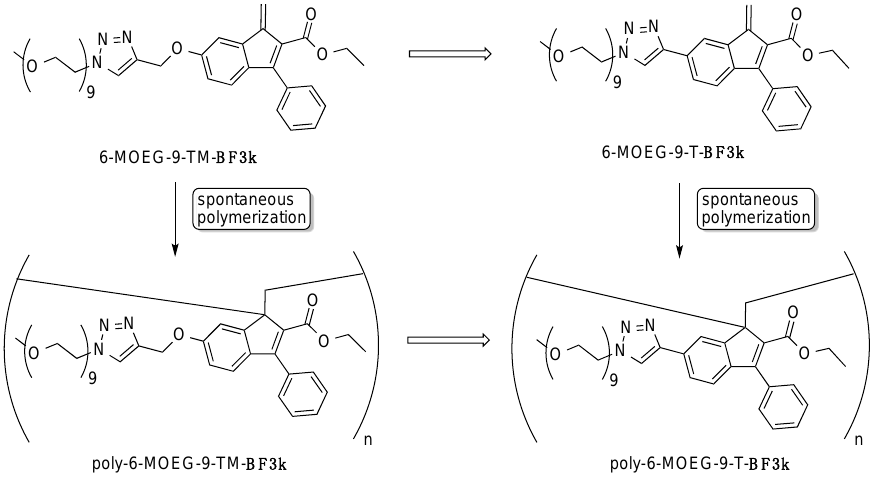
Figure 2. Design of PPBFB poly-6-MOEG-9-T- BF3k from poly-6-MOEG-9-TM- BF3k .